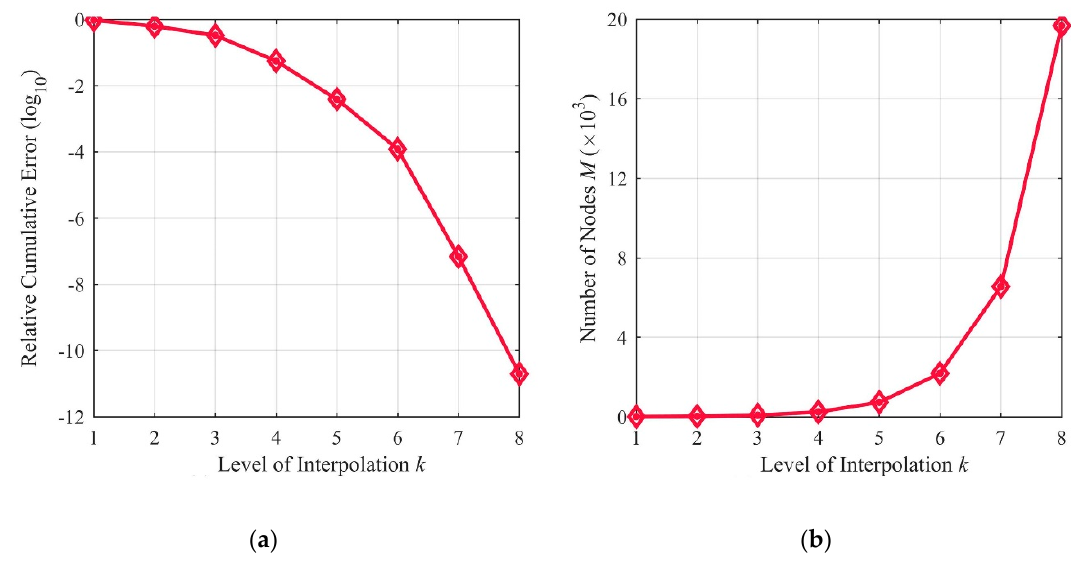
Figure 6. Influence of the level of interpolation: ( a ) Relative cumulative error; ( b ) Number of nodes.